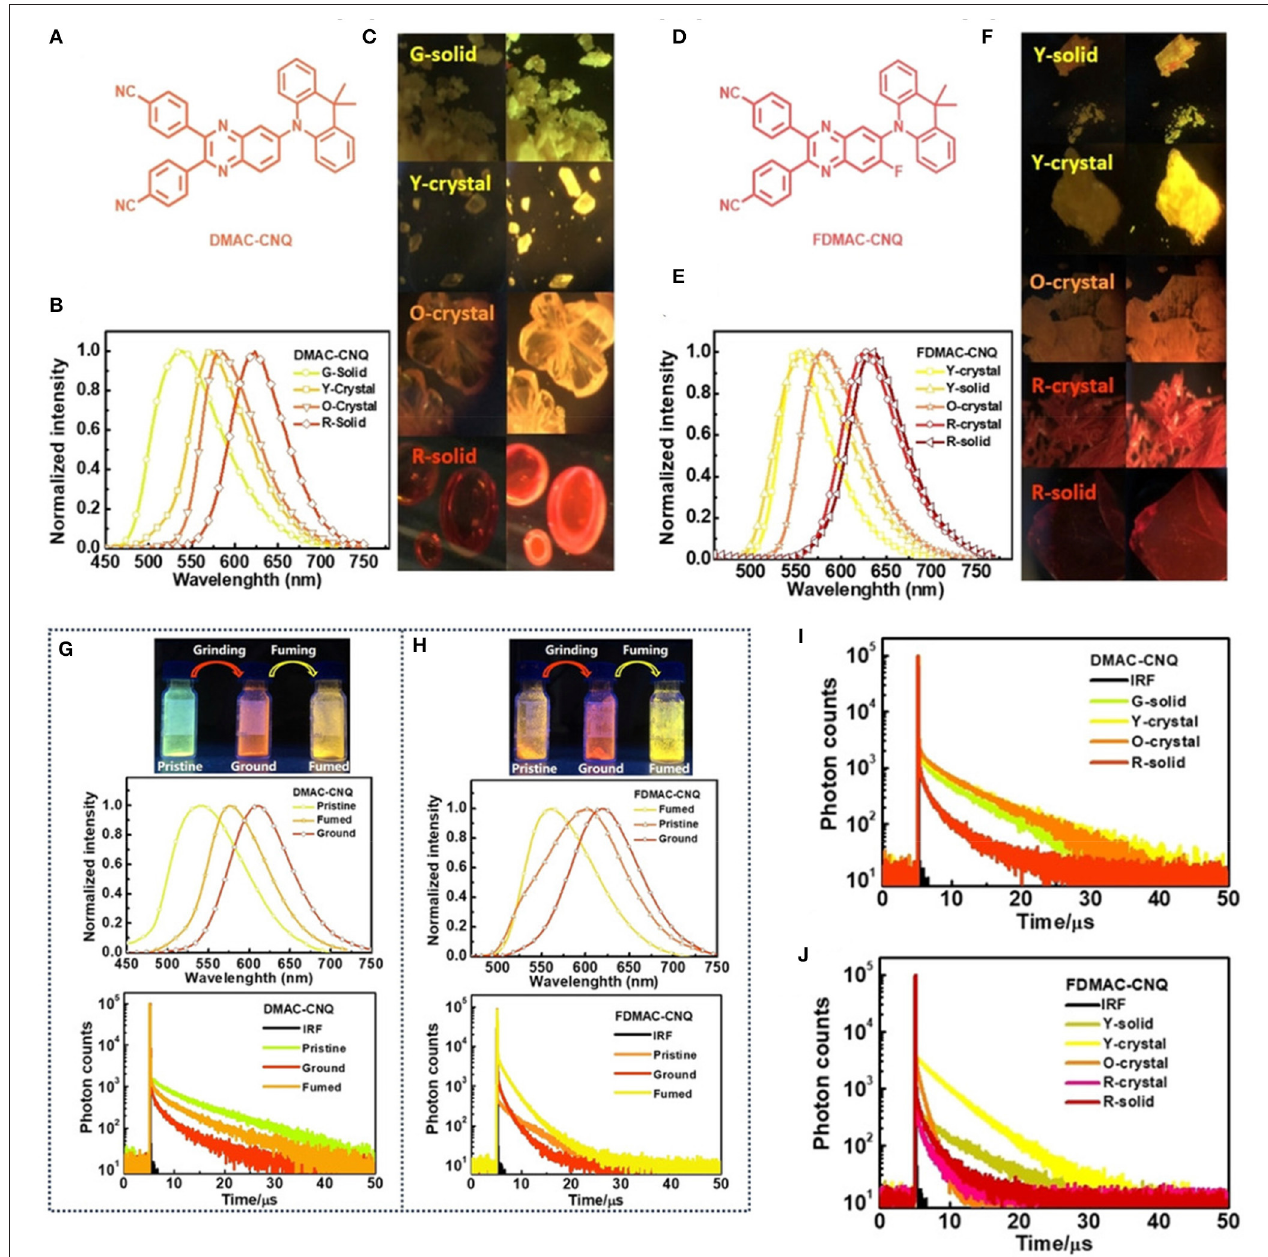
FIGURE 8 | (A–F) Chemical structures, Photographs, normalized emission spectra of obtained polymorphic solids of DMAC-CNQ and FDMAC-CNQ, respectively. (G,H) Photographs and normalized PL spectra of mechanochromism properties and (I,J) transient PL decay spectra of the two TADF-emitters. Reproduced with permission from Zheng et al. (2019a). Copyright © WILEY-VCH Verlag GmbH andamp; Co. KGaA, Weinheim.